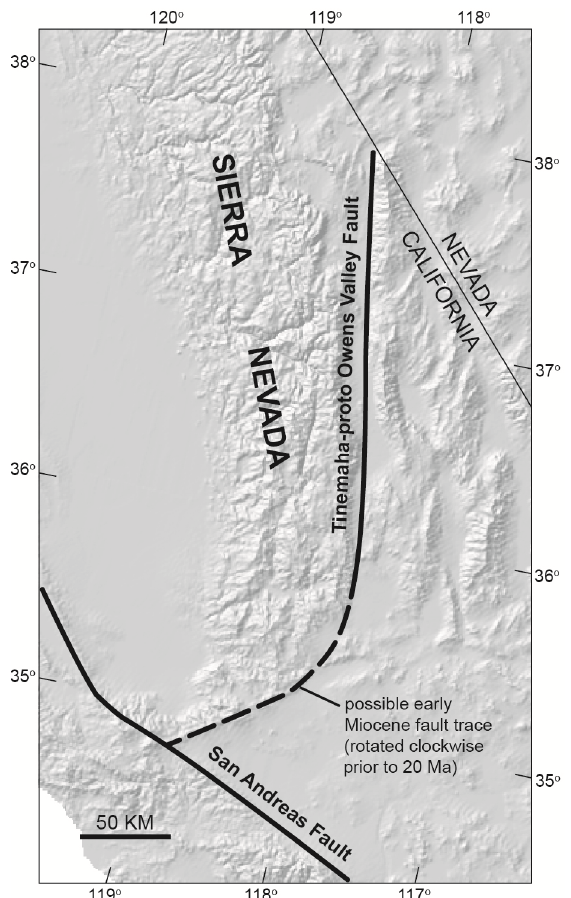
Figure 12. Map showing possible connection between the Tinemaha-proto Owens Valley Fault (T-pOVF) and the San Andreas Fault. T-pOVF could have originated as part of the early San Andreas Fault System prior to 20 Ma or older clockwise rotation of the southern Sierra